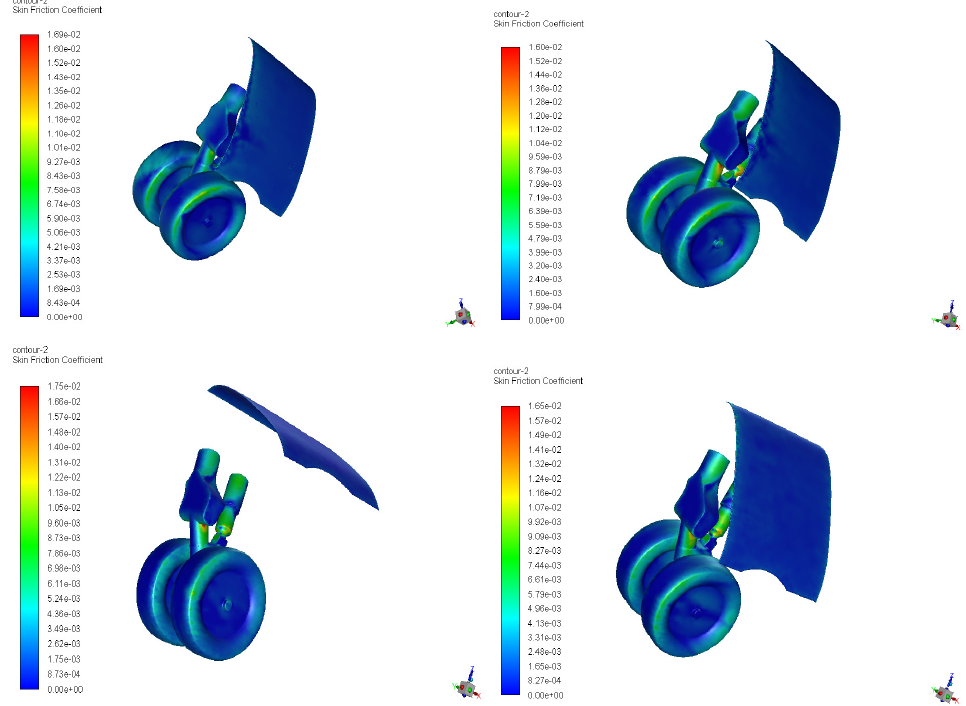
Figure 16. MLG: skin friction distribution during the lowering phase (clockwise), for the case